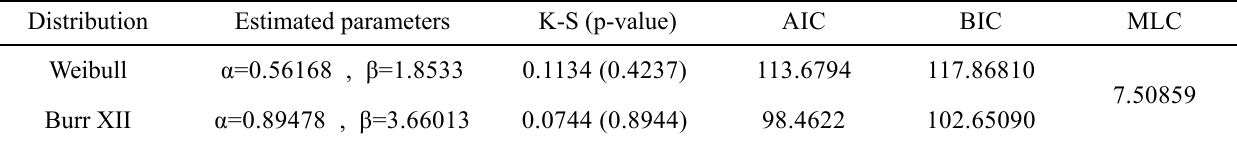
Table 1. Estimated parameters, K-S distances and AIC values for different distribution functions of the degree of splashing data. Distribution